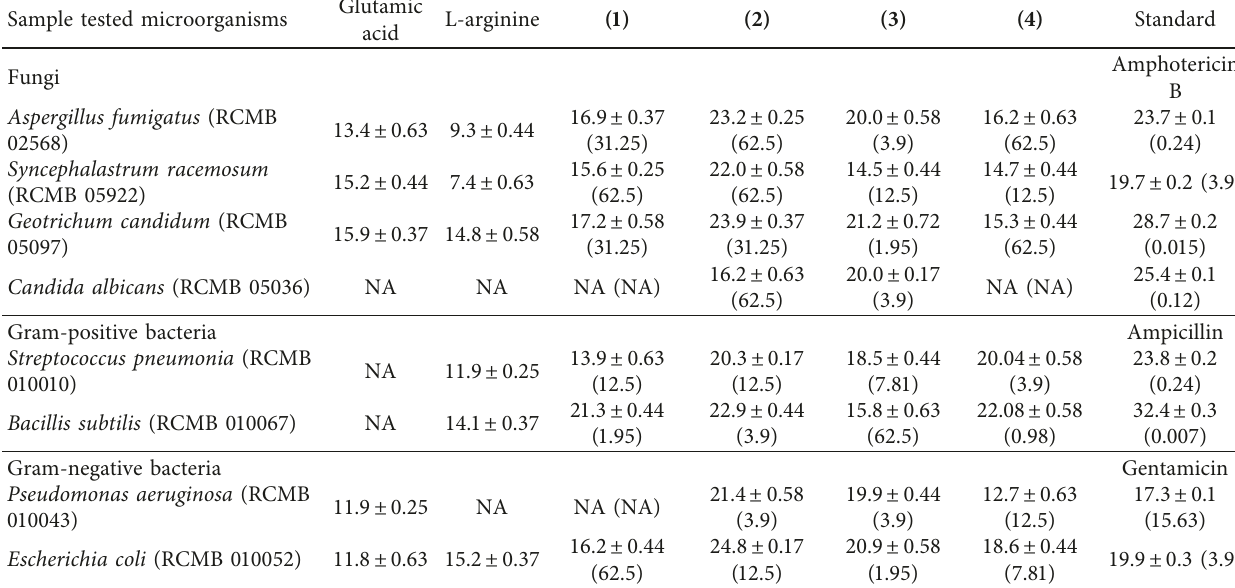
Figure 9: EDX and SEM images of Co 3 O 4 obtained by thermal decomposition at 550C ligands complex. Table 6: Antimicrobial activity of prepared ternary metal